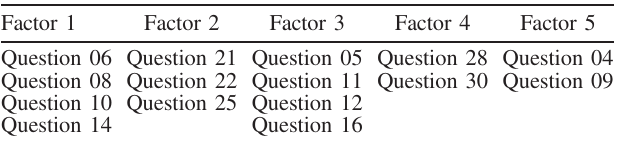
TABLE VIII. Theoretical five-factor